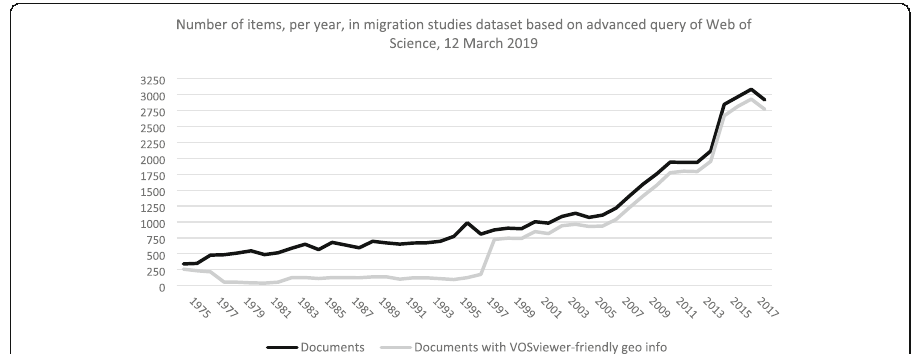
Fig. 1 Number of items, per year, in migration studies dataset based on advanced query of Web of Science, 12 March